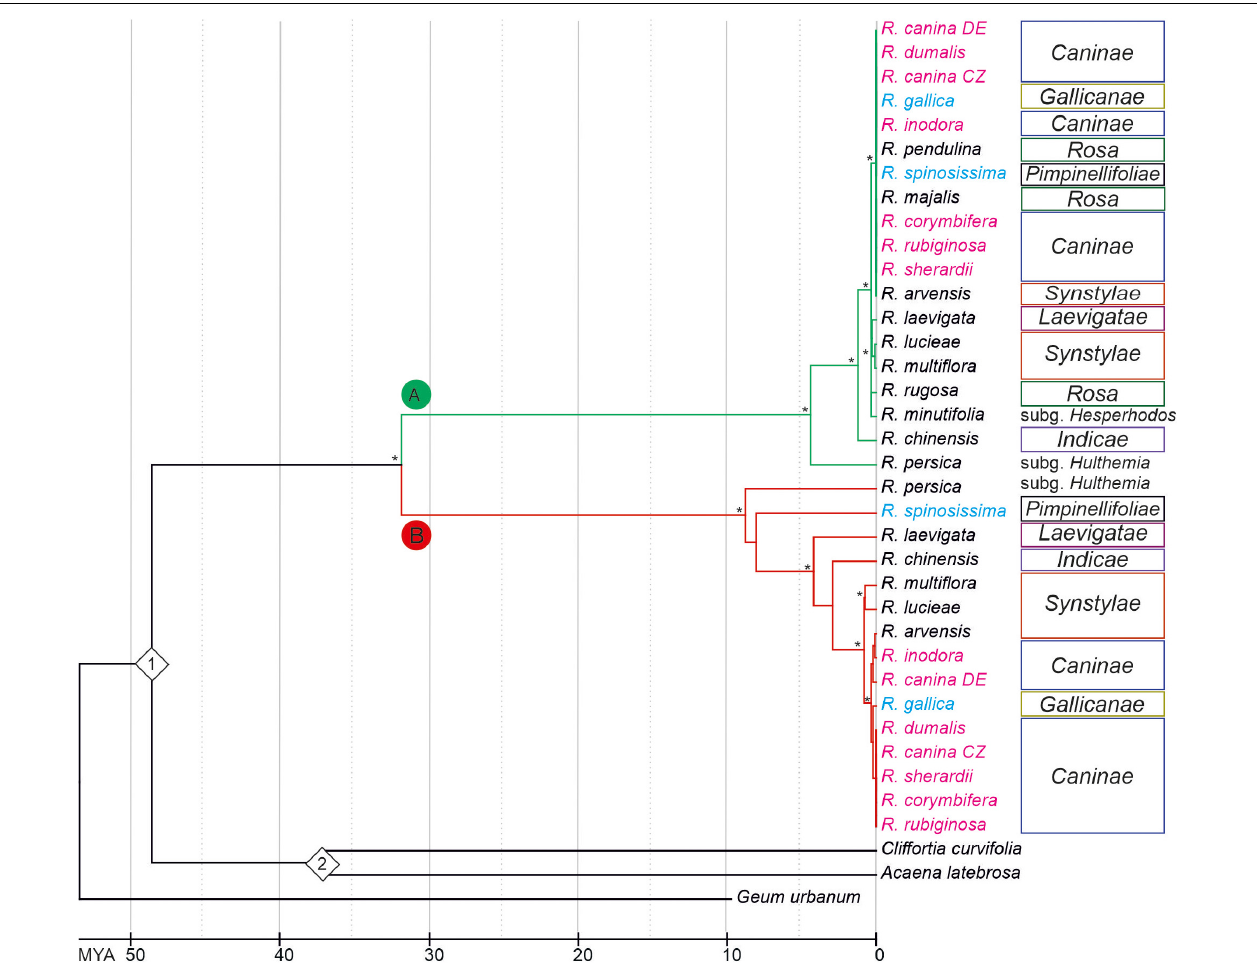
FIGURE 4 | Chronogram based on a phylogeny among Rosa species inferred from Maximum-Likelihood analysis of 5S rDNA intergenic spacers. The tree was rooted with Geum urbanum . Bootstrap value of ≥ 70% is indicated by an asterisk. Species names are colored according to ploidy level (2x—black, 4x—light blue, 5x—pink). Color of branches represents 5S_A (green) and 5S_B (red) variants of IGS rDNA. Calibration points (1 = Rosa gemerensis ; 48.6 myrs and 2 = Acaena sp.; 37.2 myrs) are indicated by diamonds.